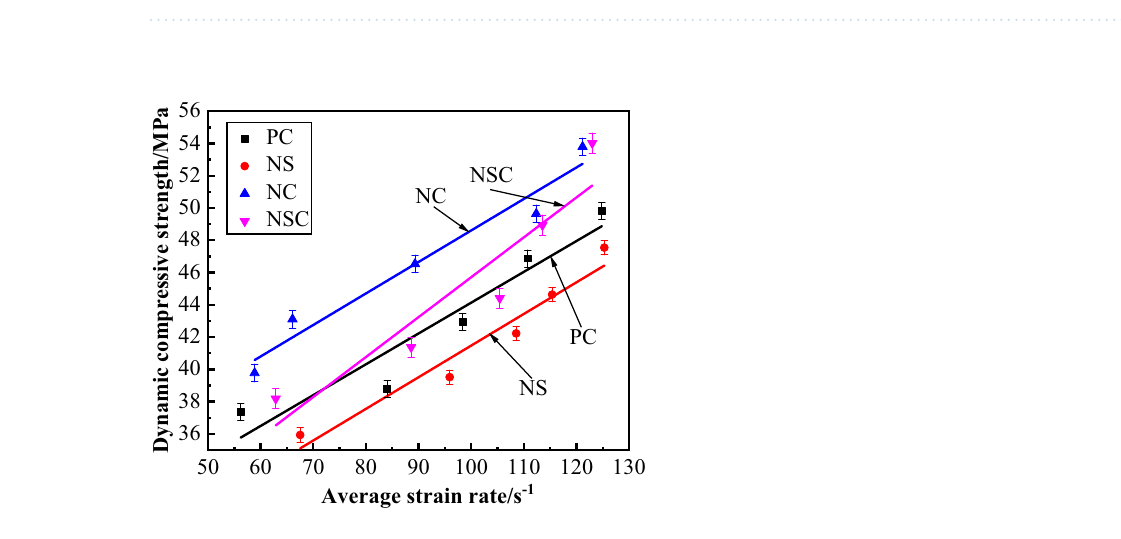
Figure 12. Relationship between dynamic compressive strength and average strain rate of